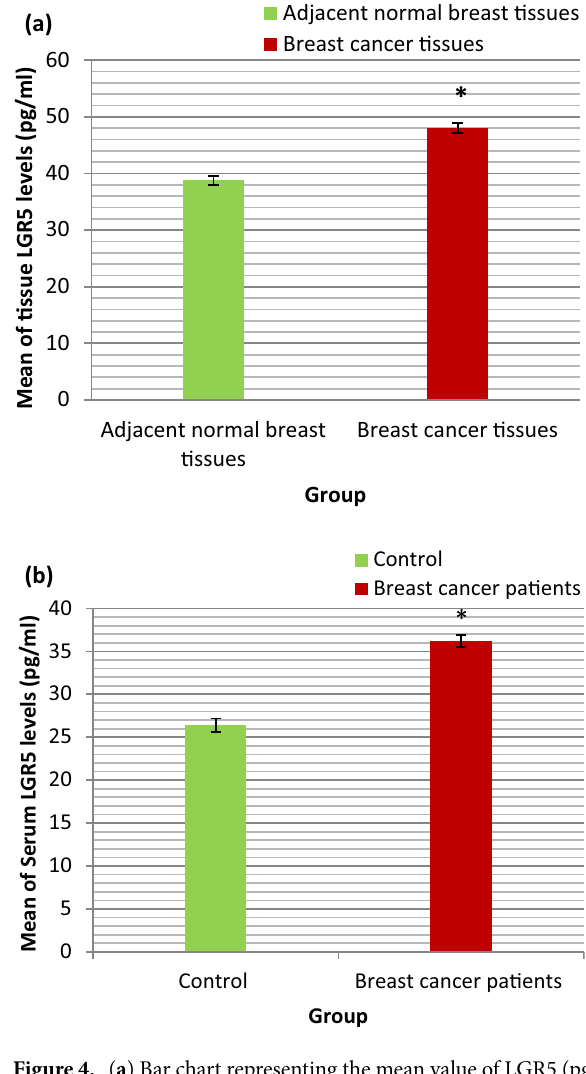
Figure 4. ( a ) Bar chart representing the mean value of LGR5 (pg/ml) in BC tissues and adjacent normal breast tissues. ( b ) Bar chart representing the mean value of serum LGR5 (pg/ml) in control group and BC patients